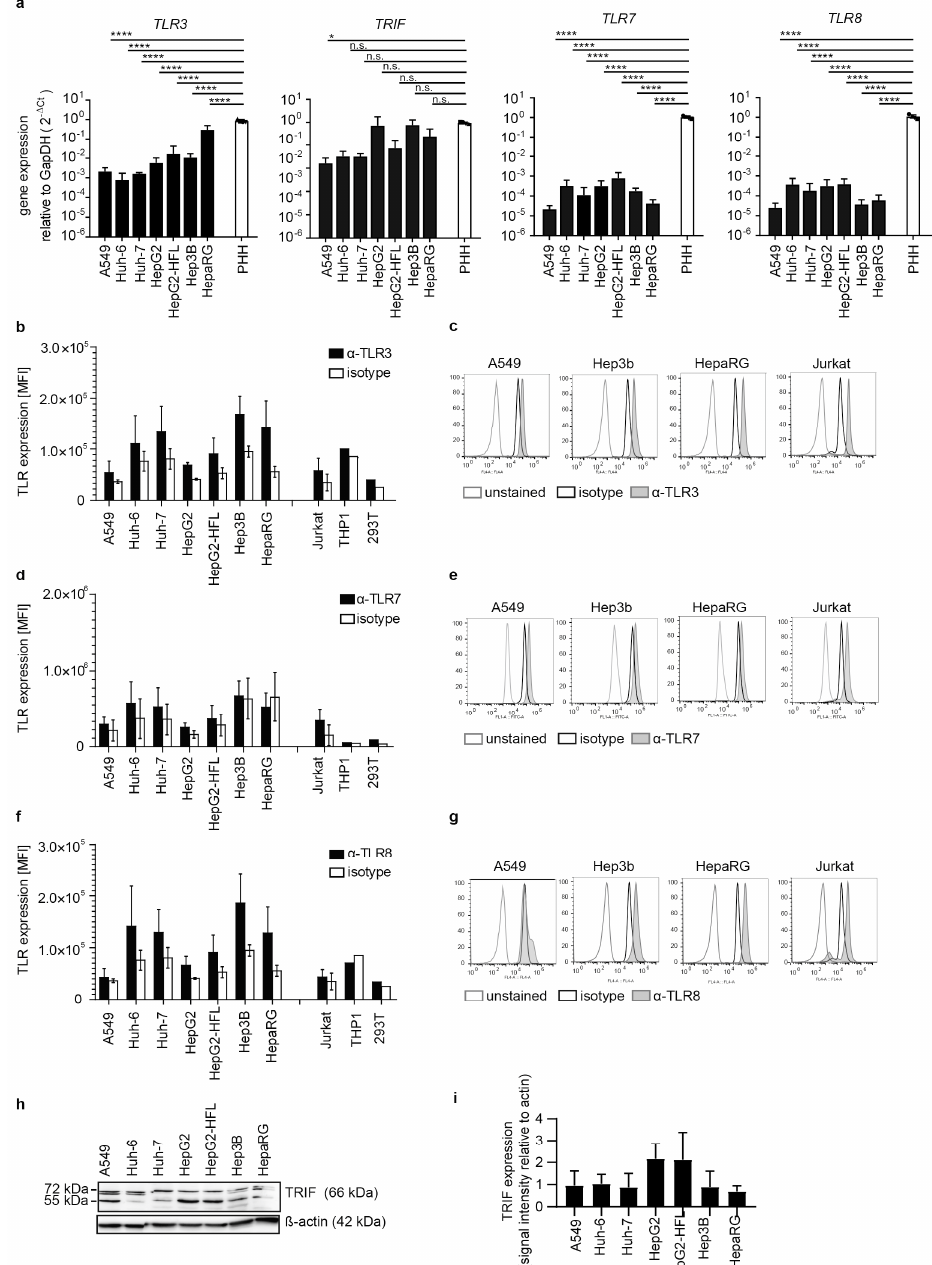
Figure 2. Transcript levels and protein expression of TLRs and the adaptor molecule TRIF in PHH and hepatoma cells. RNA expression of TLR3 , its adaptor TRIF , TLR7 , and TLR8 ( a ) in indicated cell lines and in PHH derived from four different donors, as described in Figure 1a. Flow cytometric analysis of intracellular protein expression of TLR3 ( b , c ), TLR7 ( d , e ), and TLR8 ( f , g ) in indicated cell lines. Cells were permeabilized, stained against the respective TLR, an appropriate isotype control, or left untreated. Results are shown as one representative histogram ( c , e , g ) out of three independent experiments with 30,000 events per measurement for selective cell lines or depicted as MFI ( b , d , f ) as mean ± SD of three independent experiments. Jurkat cells served as a positive control. ( h ) Immunoblot for TRIF in lysates from indicated cell lines. β -actin was used as a loading control. Results are representatives of three independent experiments. ( i ) Expression levels of TRIF quantified as immunoblot band density and shown relative to the β -actin loading control as mean ± SD of three independent experiments. One-way ANOVA, followed by Dunnett’s multiple comparison test * p < 0.05, **** p < 0.0001.